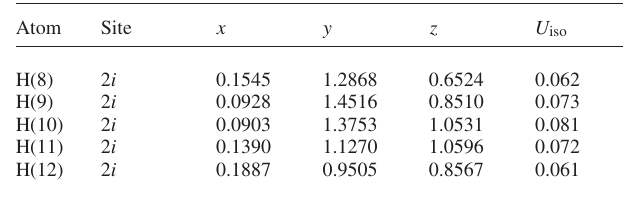
Table 2. Atomic coordinates and displacement parameters (in Å 2 )